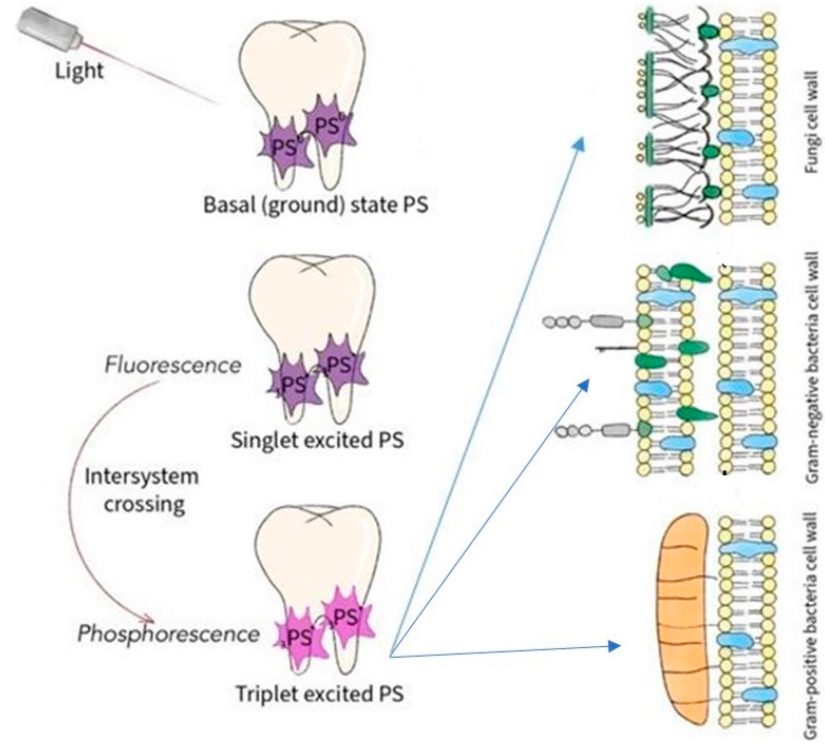
Figure 2. PDT mechanism in dentistry.